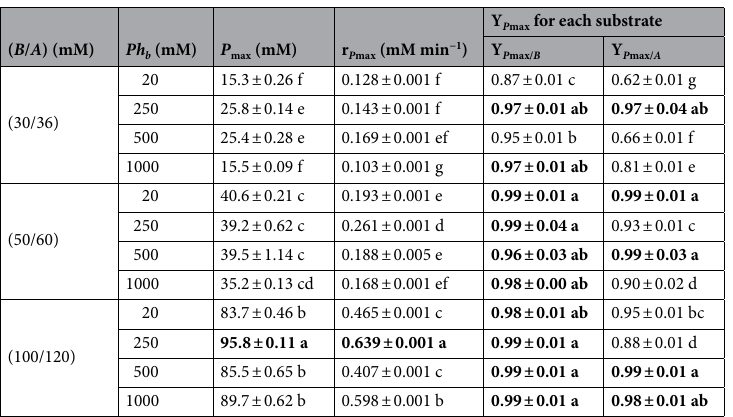
Table 1. Concentration level effects of phosphate buffer ( Ph b ) and initial substrates (benzaldehyde ( B ) as well as pyruvate ( A )) on maximum PAC production levels ( P max ), maximum PAC formation rates (r P max ), as well as corresponding PAC—substrate molar yields based on benzaldehyde (Y Pmax / B ) and pyruvate (Y Pmax / A ) being consumed at maximum PAC production level in single—phase biotransformation systems with initial volumetric enzyme activity between 1.1 and 1.5 U carboligase mL −1 . The numbers with the same alphabet (a–g) indicated no statistical significantly difference ( p > 0.05) for comparison between different rows of the same column within each group of initial substrates concentration pair. Bold numbers and alphabets showed the statistical highest values within each column. The reaction time resulting in the P max for each run could be determined by dividing P max with r P max whose value was the multiple of 30 min (30, 60, 90, 120, 150, 180, and 210 min). Rounding-off errors of the tabulated values might result in non-integer reaction times which should be rounded to the nearest multiple of 30 min, for instance, reaction time for PAC biotransformation with initial substrates ( B , A ) of (30, 36) mM in 250 mM phosphate buffer producing P max of 25.8 mM was 25.8 mM/0.143 mM min −1 = 180.42 ≈ 180